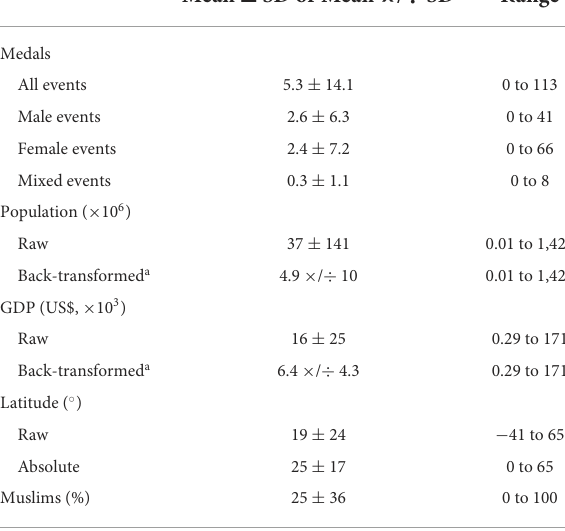
TABLE 1 Descriptive statistics of the 91 nations that attended the Pyeongchang winter Olympics in 2018. Mean ± SD or Mean × / ÷ SD